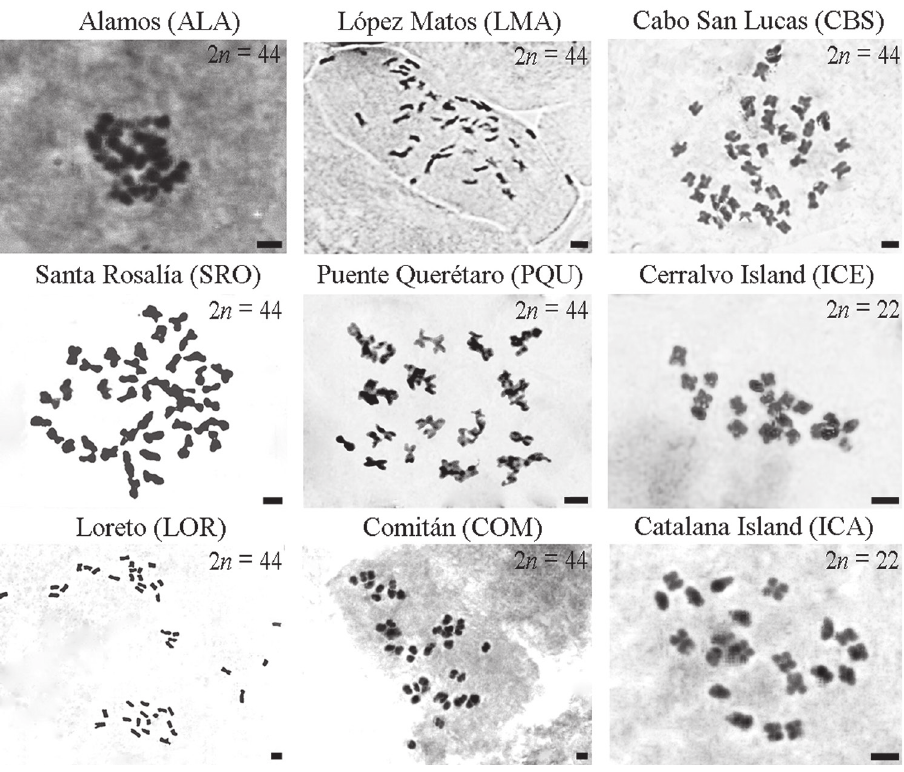
Figure 2. Representative metaphase chromosomes of Pachycereus pringlei. Cerralvo Island (ICE) and Catalana Island (ICA) are the sole localities for diploid cytotypes. Remaining pictures in plate are typical chromosomes in different tetraploid populations. Scale Bar: 2